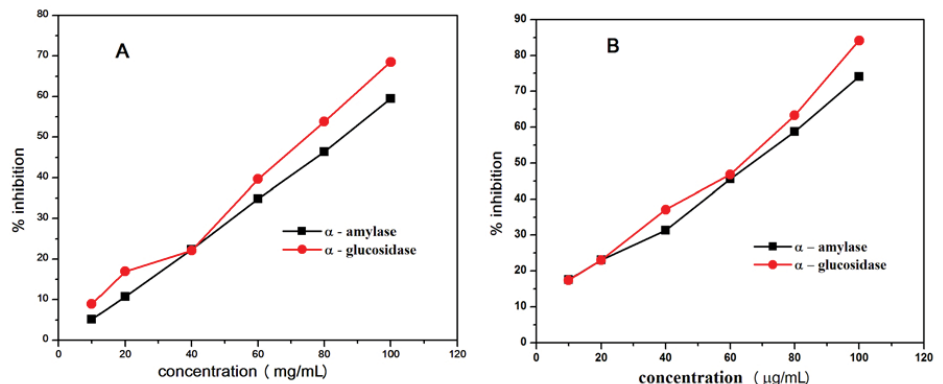
FIGURE 1 – Comparision of α-amylase and α-glucosidase inhibition. A: % inhibition of α-amylase and α-glucosidase against various concentrations of S.oblonga. B: % inhibition of α-amylase and α-glucosidase against various concentrations of